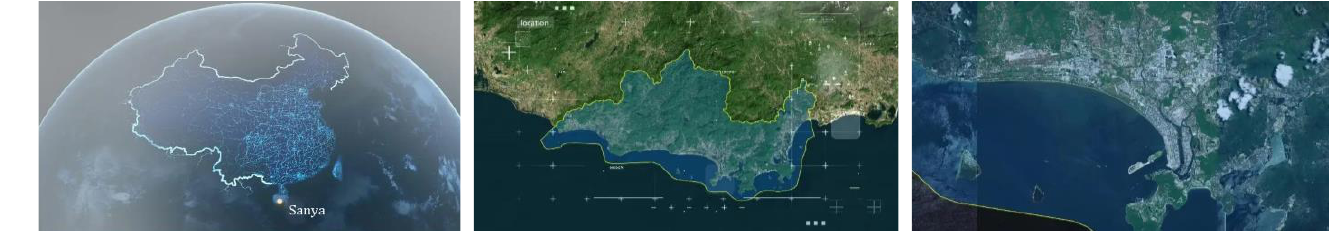
Figure 3. Map of Sanya.